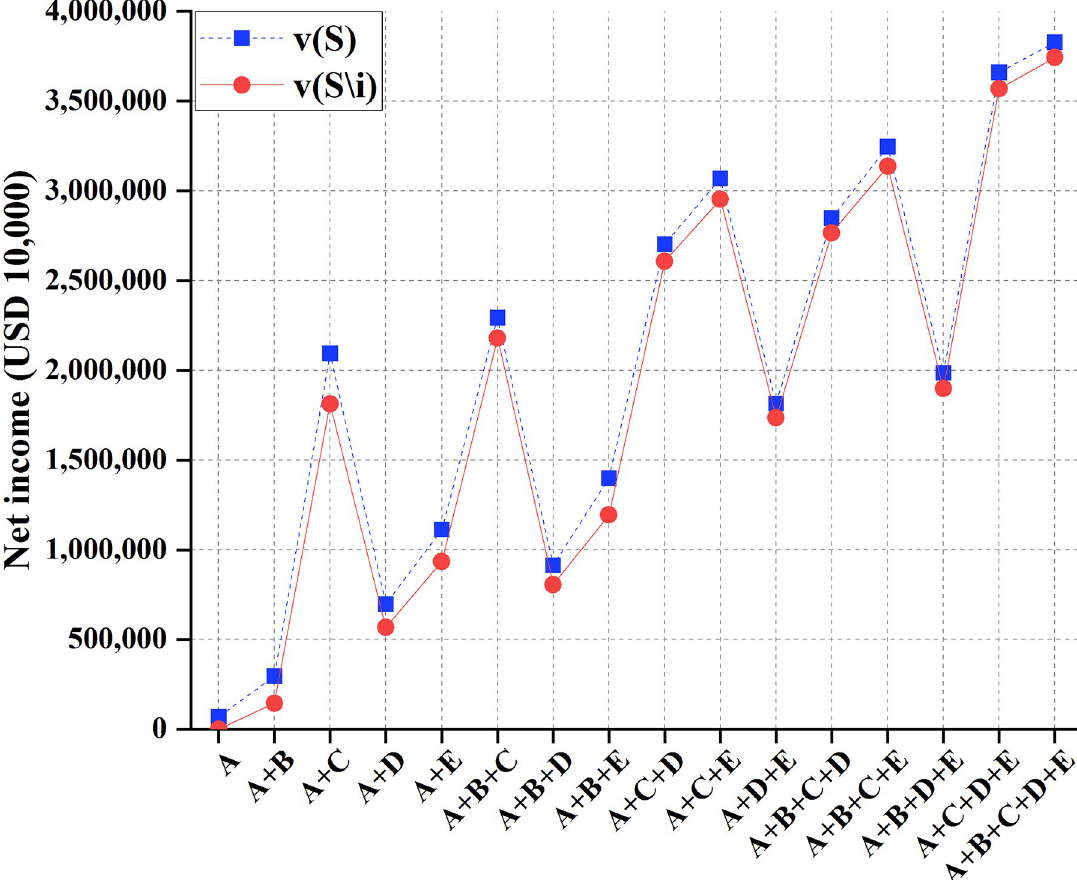
Fig 11. Profit comparison of 16 cooperation modes among China and other four